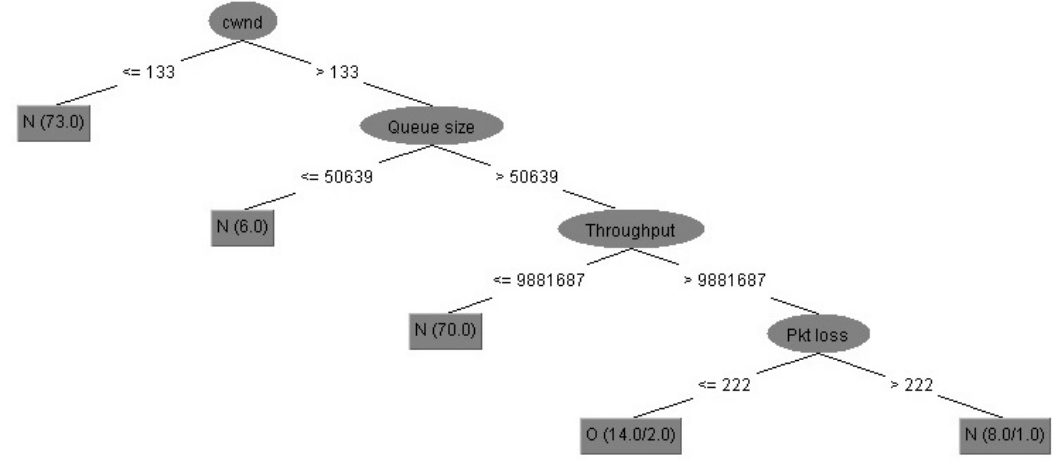
Figure 6. Congestion control DT.